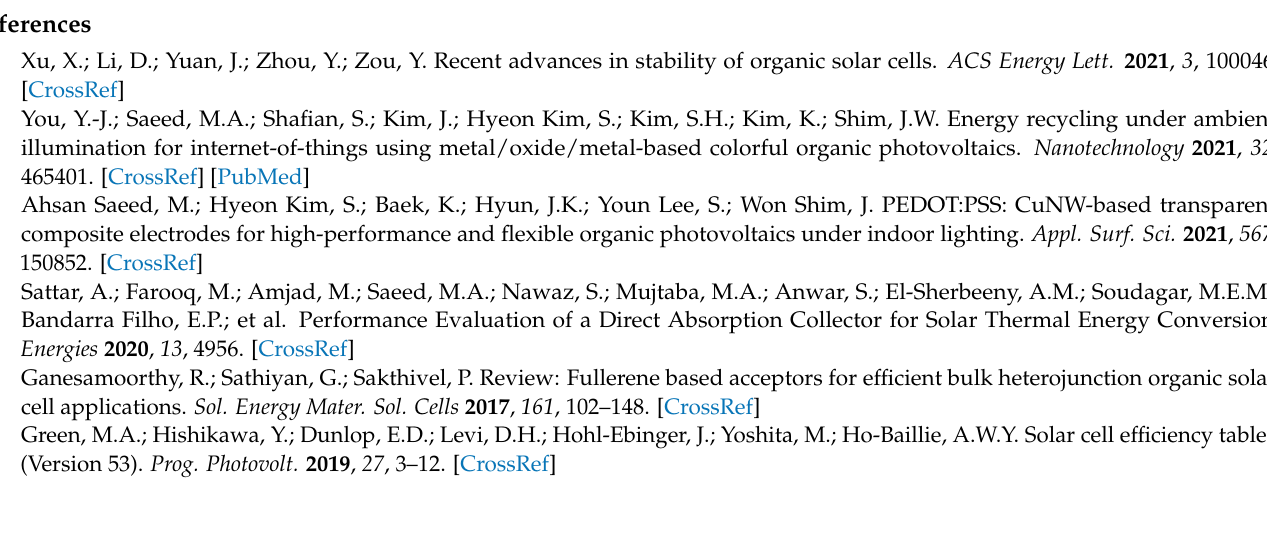
Figure 8. Contour plots of the exciton generation as a function of x and 𝜆 in ( a ) inverted and ( b ) conventional